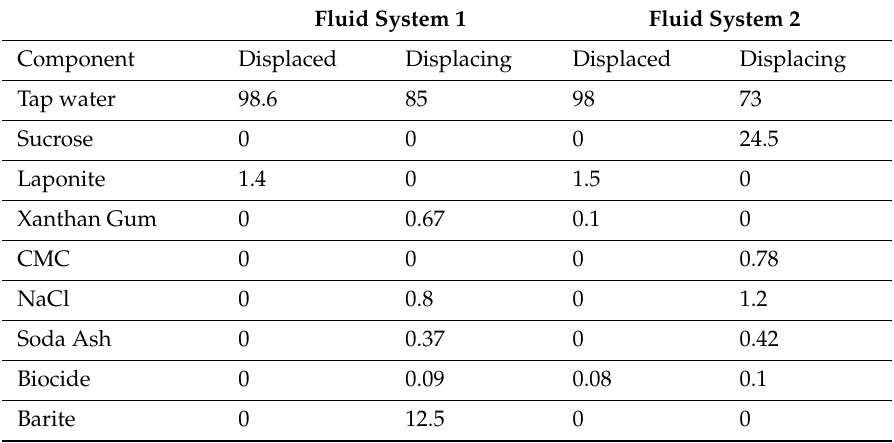
Table 1. Fluid composition by mass percentage for the fluids